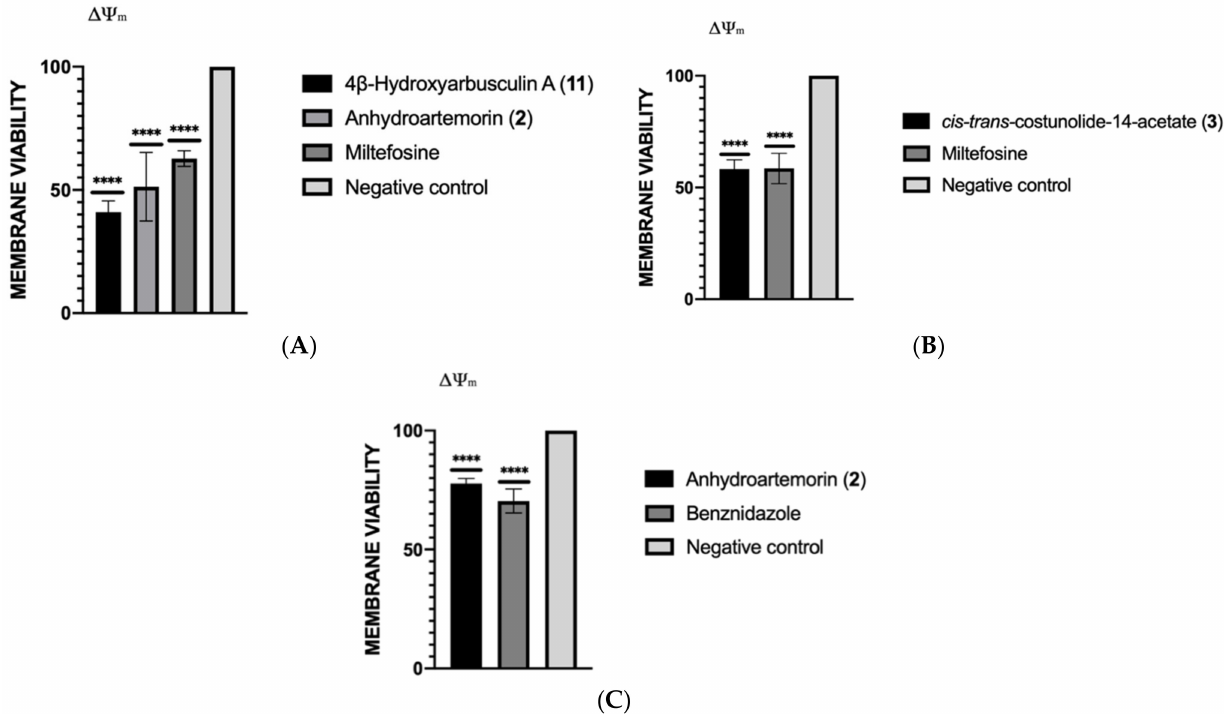
Figure 5. Mitochondrial membrane potential relative to the negative control in L. amazonensis ( A ), L. donovani ( B ) and T. cruzi ( C ). A one-way ANOVA by GraphPad.PRISM ® 9.0 software was performed to know the statistical differences between compounds and untreated control ( p < 0.0001 [****]) ( n =